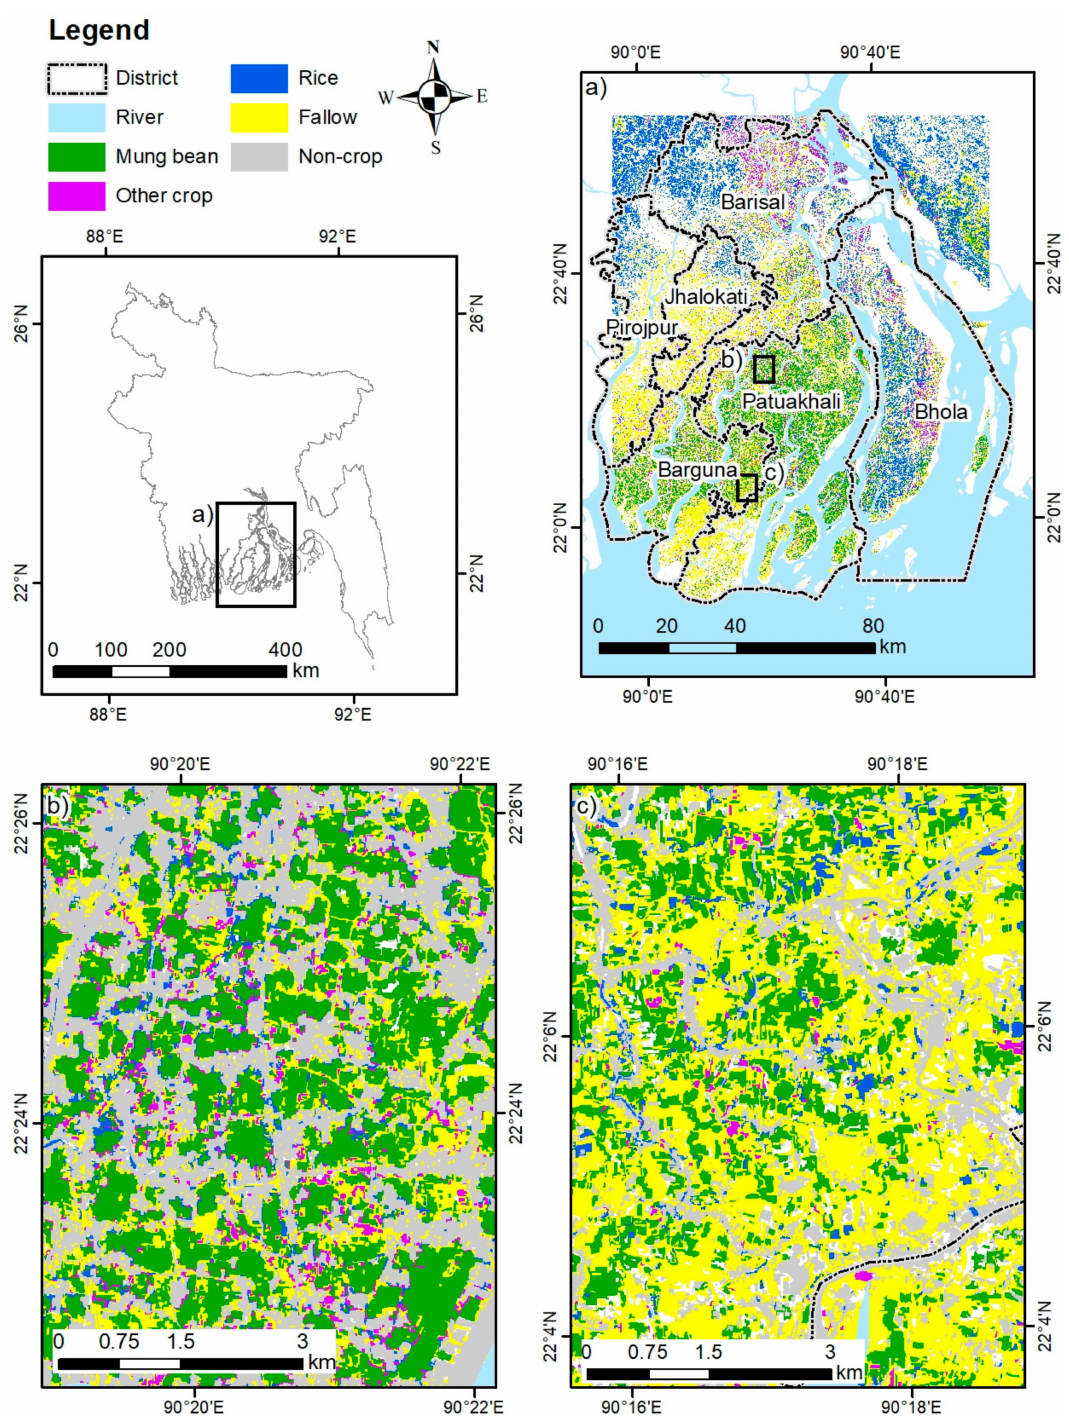
Figure 11. ( a ) Classified spatial distribution of the four major crop types cultivated in the Barisal division of coastal Bangladesh during the mung bean growing season from February 6 through 17 April 2019. The locations of panels ( b , c ) are marked with a black rectangle on ( a